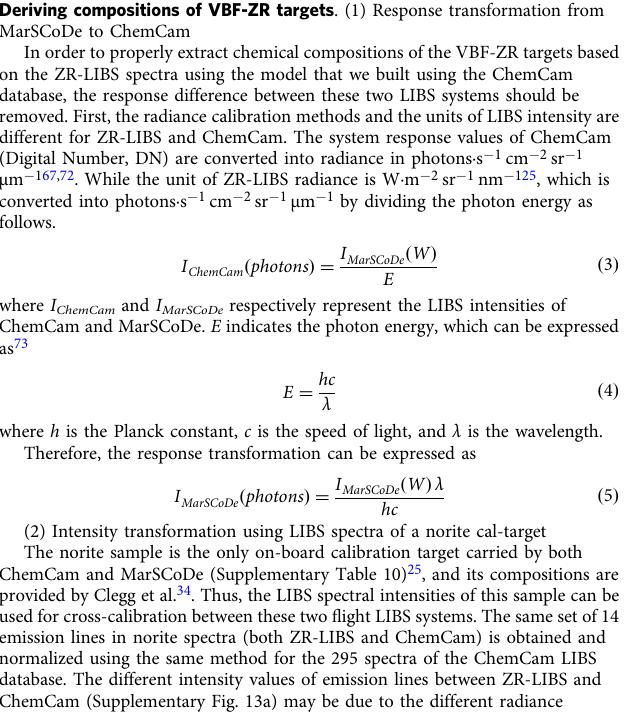
algorithm to predict the oxide abundance of eight major oxides (SiO 2 , TiO 2 , FeO T , MgO, Al 2 O 3 , CaO, Na 2 O, and K 2 O). Polynomial fi tting is selected with the intent to reduce the disturbance effects in LIBS intensities between elements (i.e., chemical matrix effects). The performance of this model is determined by RMSE between actual and derived compositions as